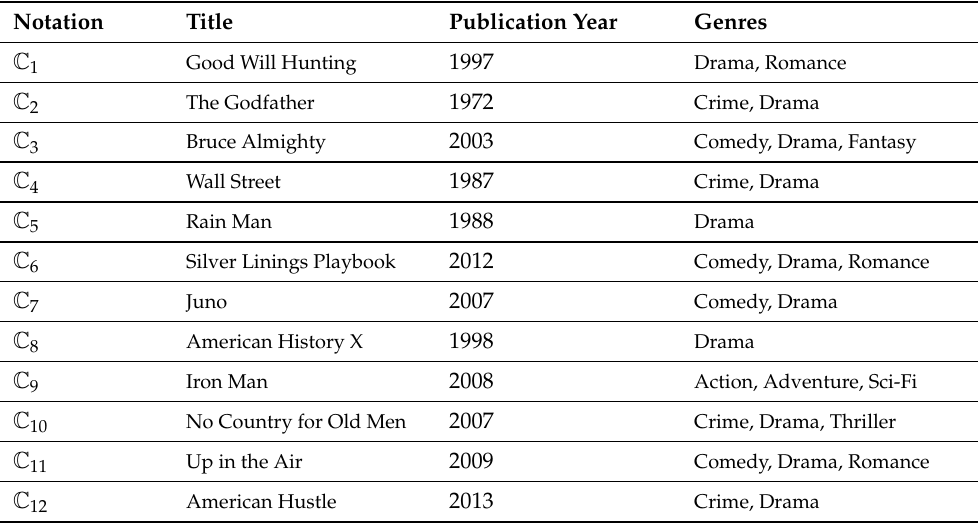
Table 1. A list of movies that have been used for evaluating the proposed methods for decomposing and analyzing plot